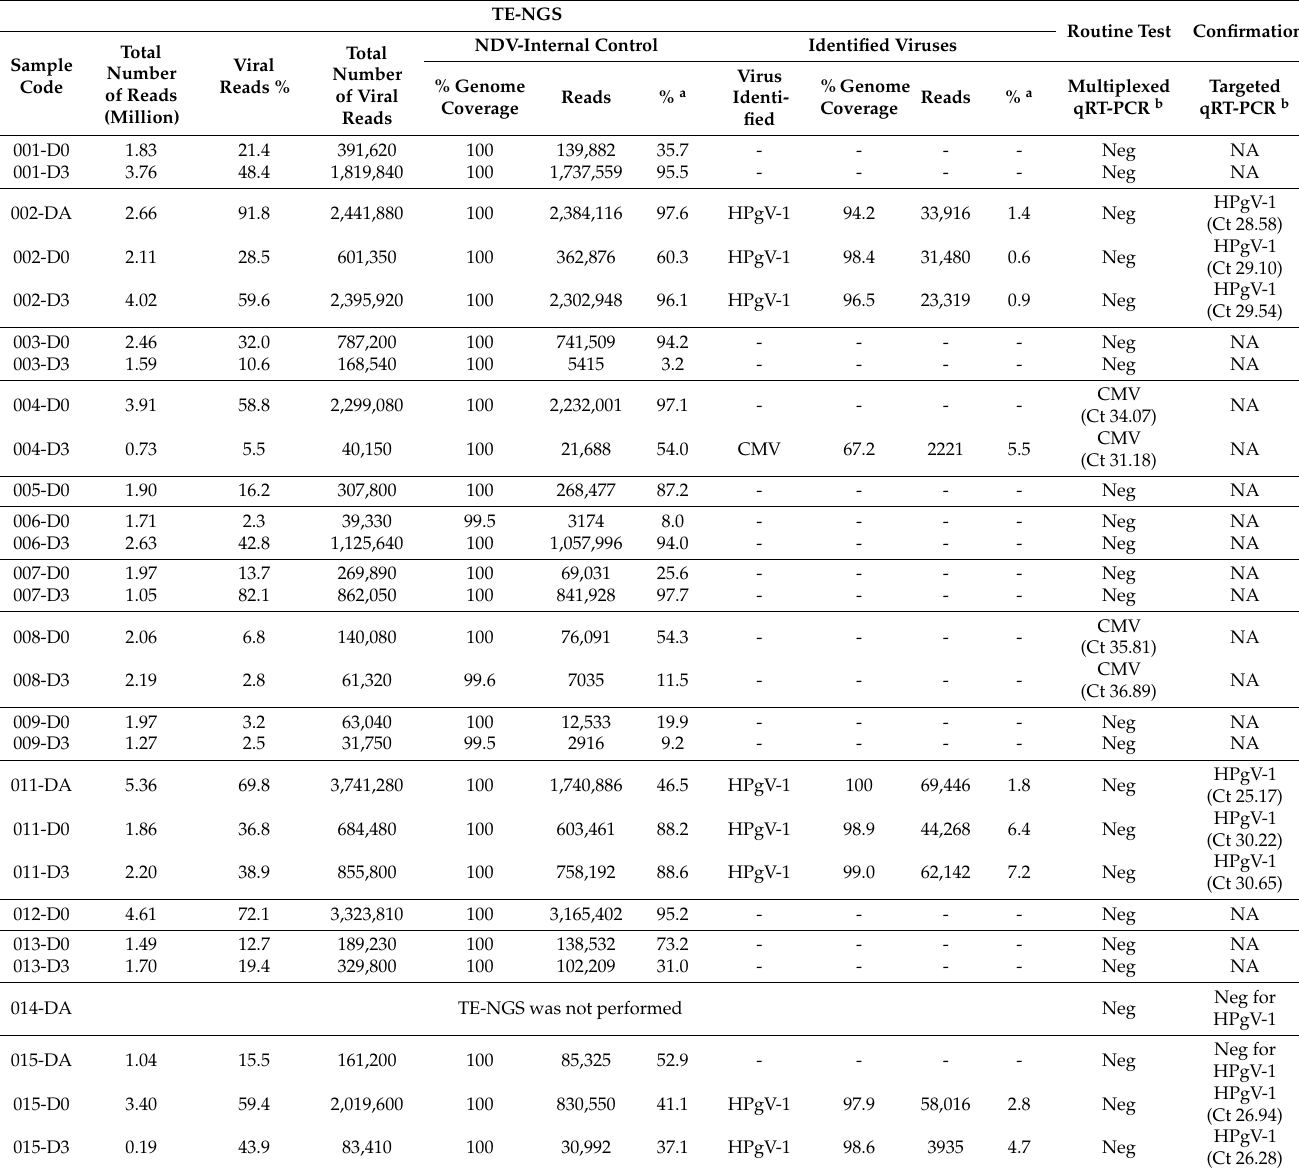
Table 2. Summary of the viral sequences detected in the target enrichment next-generation sequencing (NGS) data using Virus Identification Pipeline, VIP